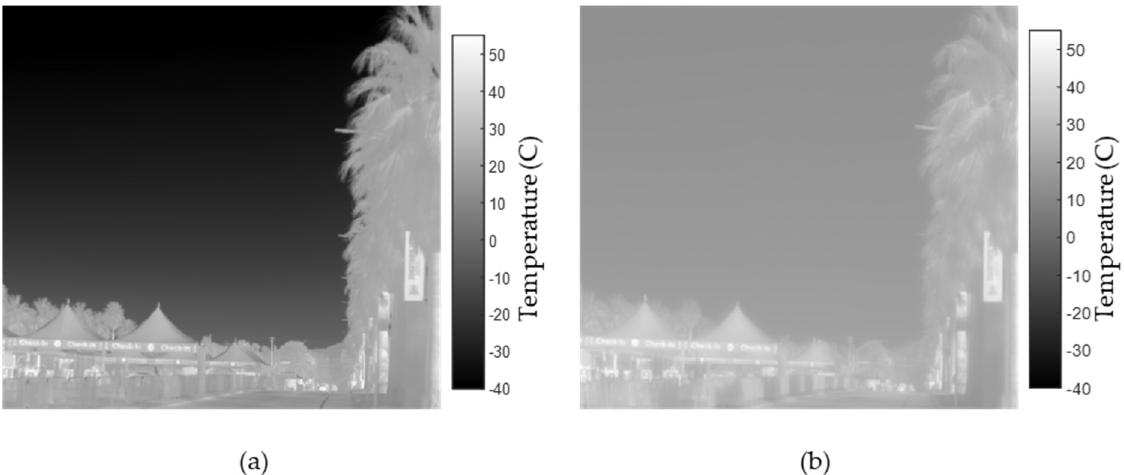
Figure 1. Sky temperature map of Tucson, Arizona, measured in degrees Celsius for the horizon to approximately 20 ◦ elevation near midday on 25 February 2021: ( a ) LWIR image taken with FLIR T1020; ( b ) MWIR image taken with TELOPS M1k.